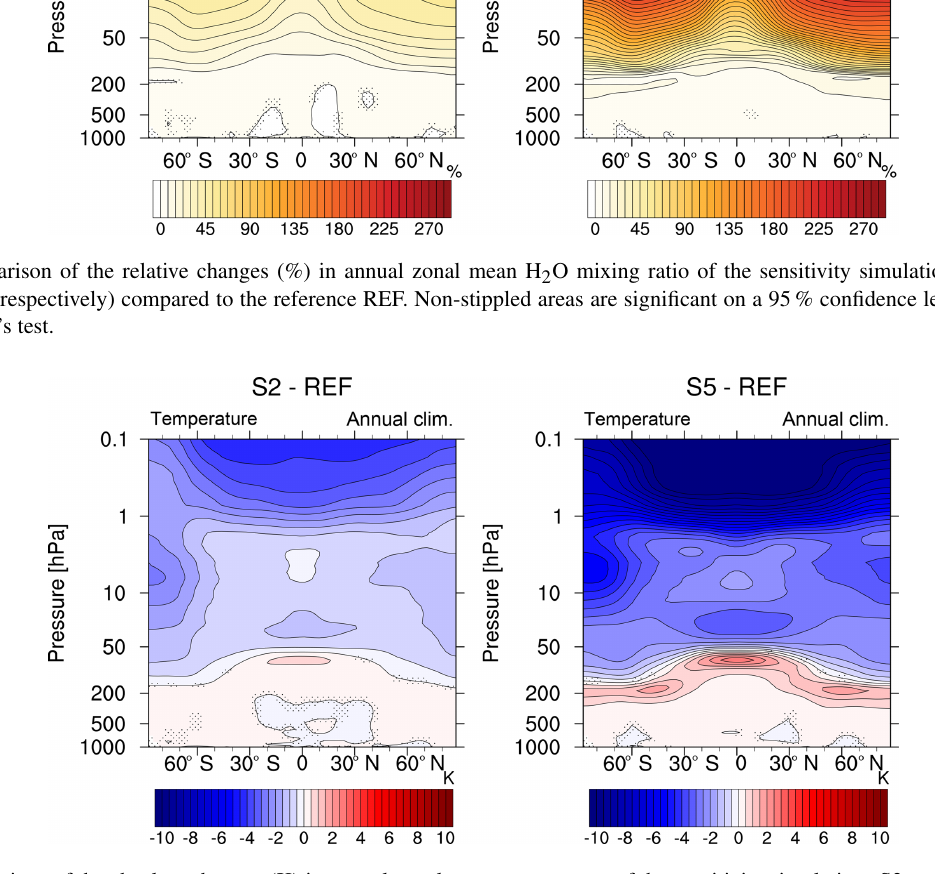
Figure 6. Comparison of the absolute changes (K) in annual zonal mean temperature of the sensitivity simulations S2 and S5 (2- and 5-fold CH 4 , respectively) compared to the reference REF. Non-stippled areas are significant on a 95% confidence level according to a two-sided Welch’s